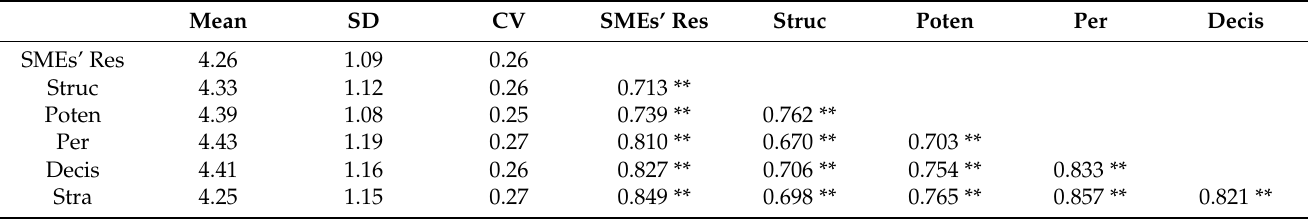
Table 3. Mean, standard deviations, and coefficient